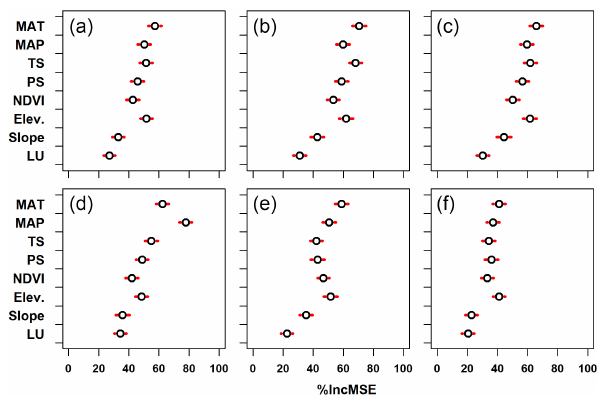
Figure 7. Importance of variables, denoted by the percent increase in mean-square error (%IncMSE) for each soil property estimation: (a) BD (bulk density, gm − 3 ), (b) sand fraction (%), (c) clay frac- tion (%), (d) pH, (e) SOCD (soil organic carbon density, kgm − 2 ) and (f) STND (soil total nitrogen density, kgm − 2 ). MAT, MAP, TS, PS, Elev. and LU indicate mean annual temperature, mean annual precipitation, annual temperature seasonality, annual precipitation seasonality, elevation and land use type,